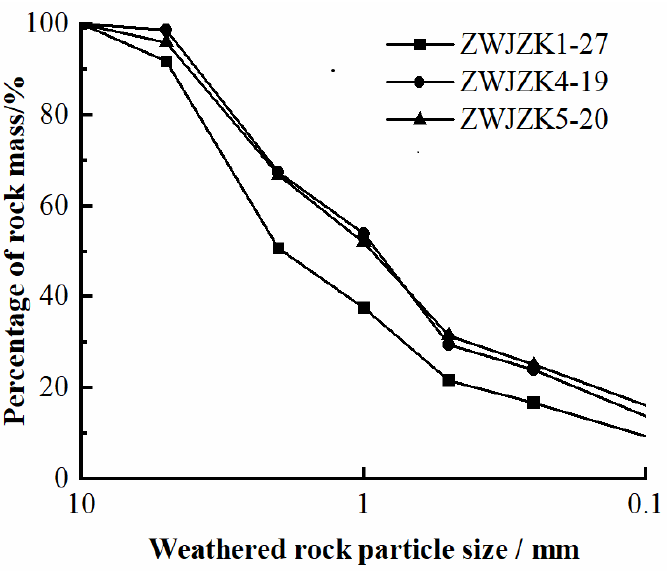
Figure 1. Analysis curve of weathered granite particles.